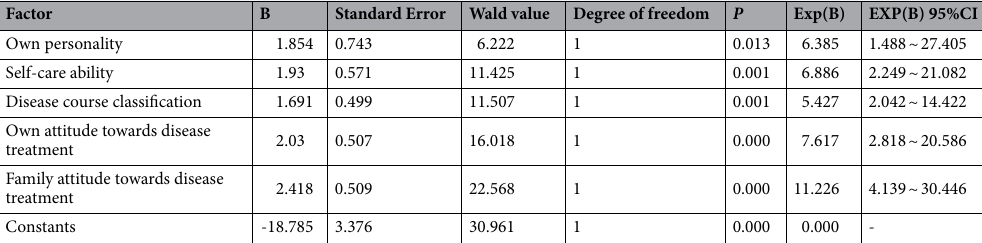
Table 3. Analysis results of logistic regression by gradual regression method.